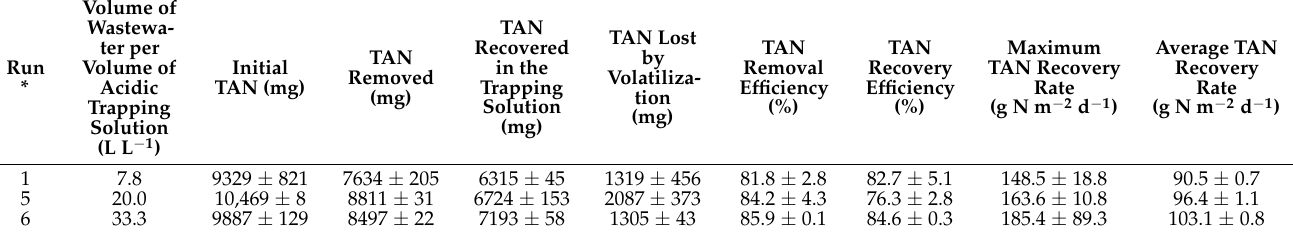
Table 3. Mass balance of the recovery of ammonia using gas-permeable membrane for Runs 1, 5, and 6 (effect of the volume of wastewater per volume of acidic trapping